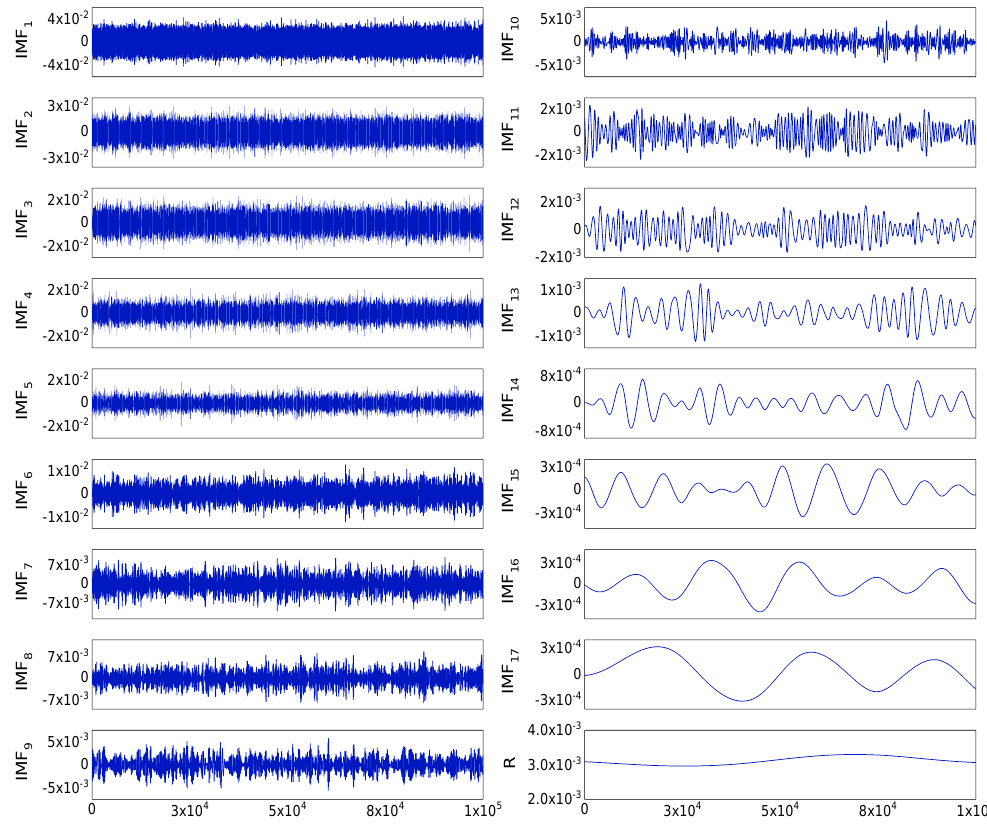
Figure 5. The decomposed intrinsic mode functions (IMFs) and the residual (R) of the noisy signal.